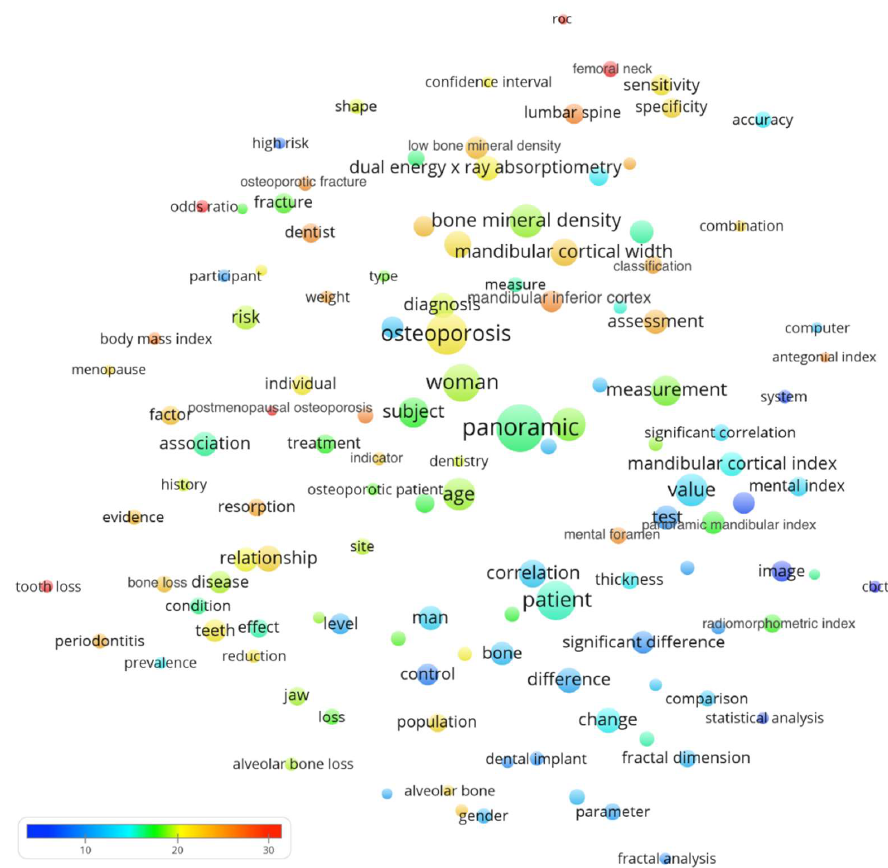
Figure 1. Bubble map showing words or phrases that appeared in at least ten of the 280 papers. We excluded generic terms by a visual inspection of the map generated in the preliminary stage. After screening, 123 terms remained. The bubble size indicates the number of papers containing the term. The bubble color indicates its citation per paper. If the terms frequently co-appeared in the same papers, their bubbles were in closer proximity. The x - and y -axis carried no specific information and only proximity between bubbles should be considered. Some of the measurement indices might appear under different names.